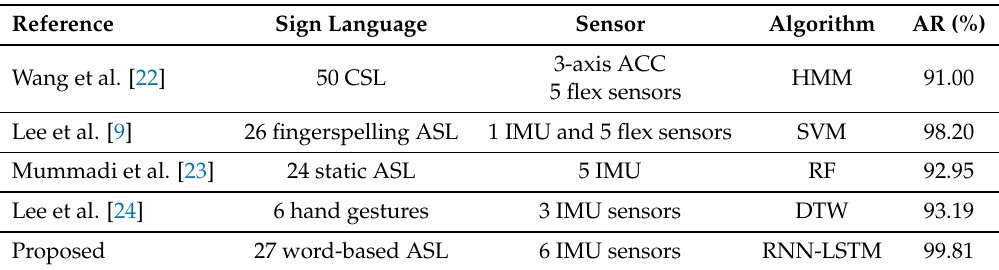
Table 6. Comparison of sign language recognition sensor